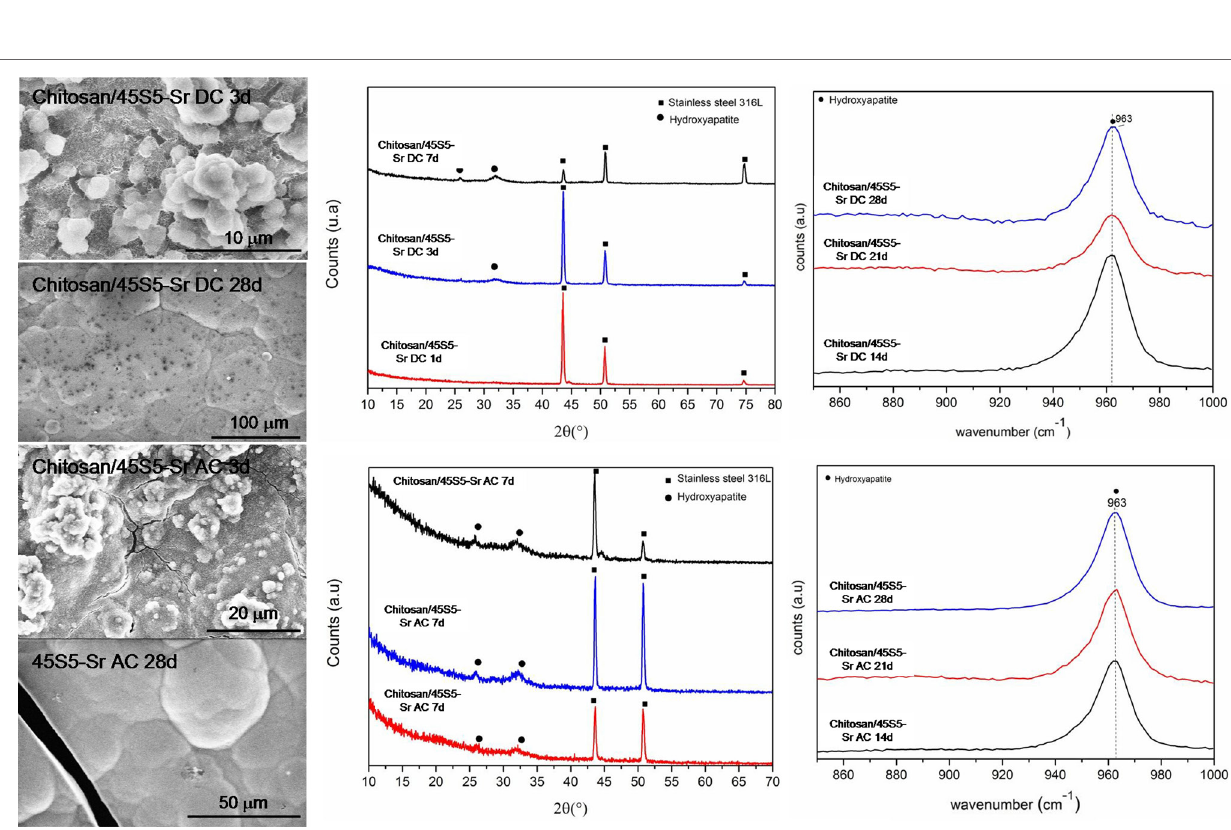
FigUre 11 | seM, XrD, and raman analyses of 45s5-sr up to 1 month of sBF immersion